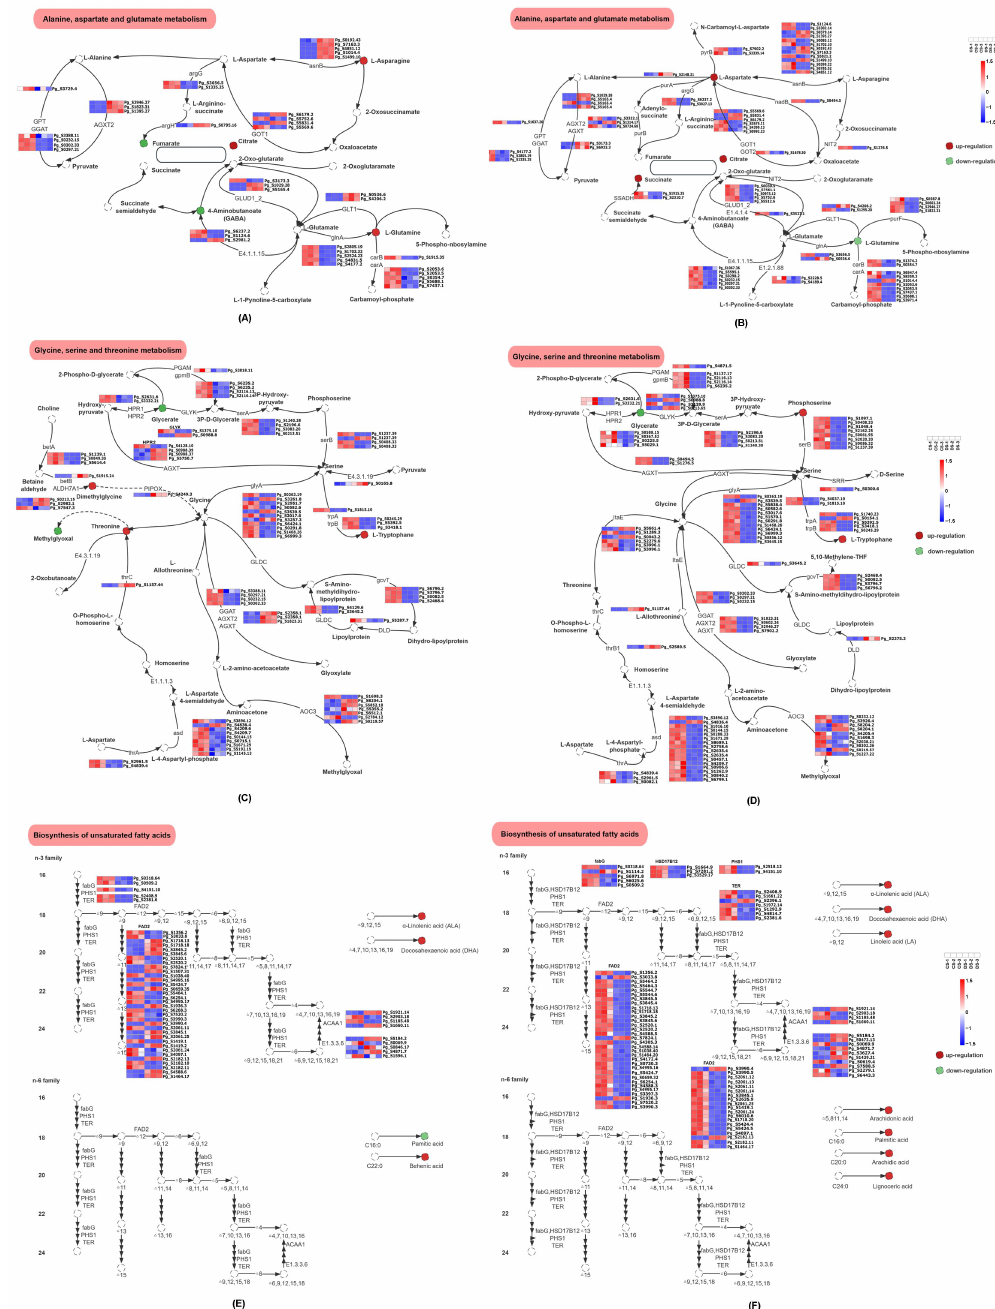
Figure 11. SDMs and DEGs in pathways of “Alanine, aspartate and glutamate metabolism”, “Glycine, serine and threonine metabolism”, and “Biosynthesis of unsaturated fatty acids” in ginseng leaves ( A , C , E ) and stems ( B , D , F ). Upregulated SDMs were depicted in red circles; downregulated SDMs were depicted in green circles. 1.5 and −1.5 depict the highest and the lowest relative abundance, respectively. SDMs: disease-related metabolites.